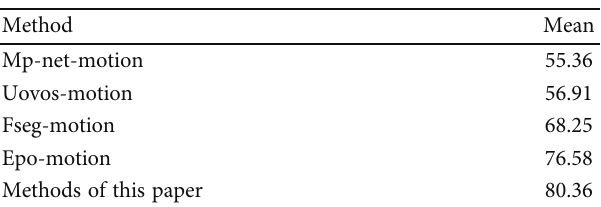
Table 1: Comparative experiment of motion saliency segmentation network on